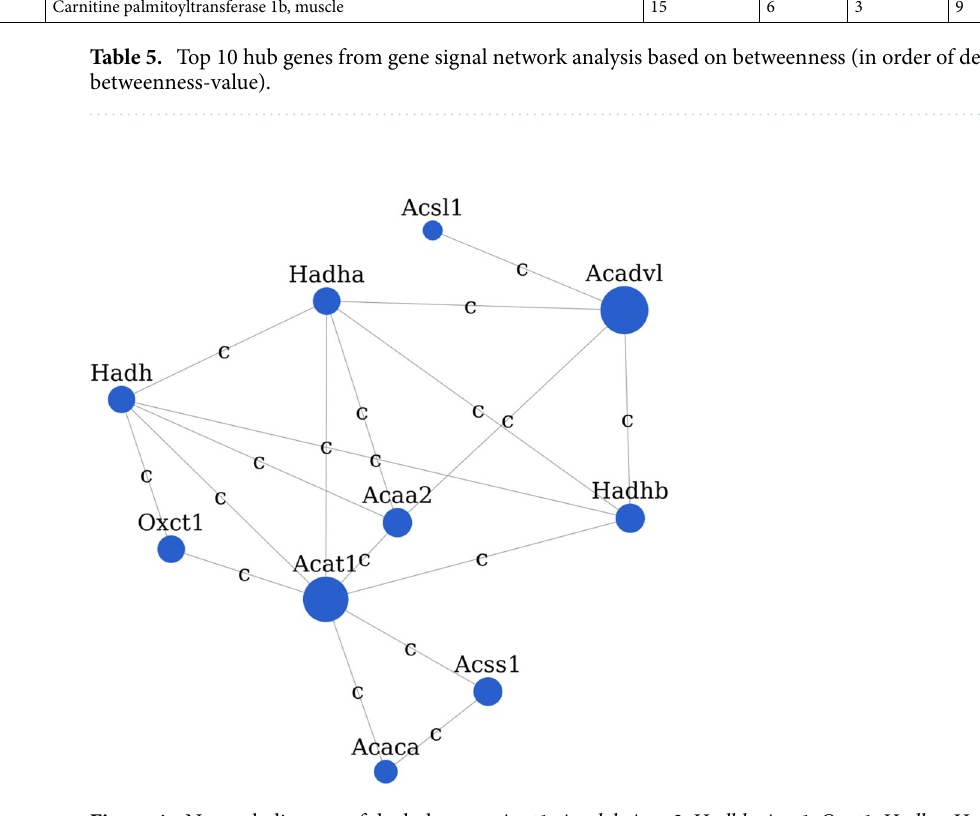
Figure 4. Network diagram of the hub genes Acat1 , Acadvl , Acaa2 , Hadhb , Acss1 , Oxct1 , Hadha , Hadh , Acaca , and Cpt1b . Each dot in the figure represents a gene. Larger points indicate greater betweenness values. Blue dots represent downregulated genes. Lines indicate interaction between two genes, and the labels are the abbreviations of the type of interaction between the two genes (compound: c). Solid lines without arrows indicate non-directional